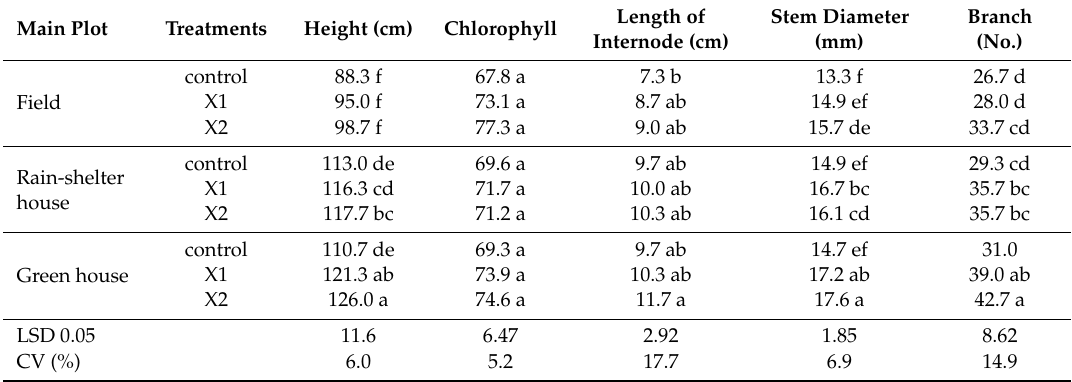
Table 4. Plant growth attributes at 130